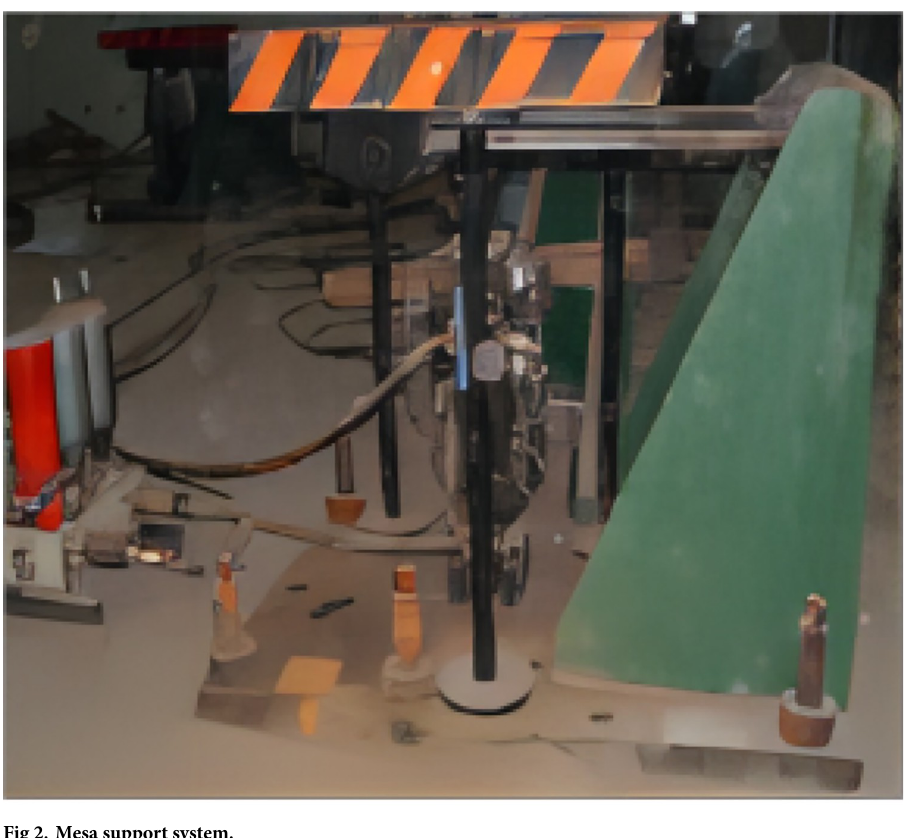
Fig 2. Mesa support system.